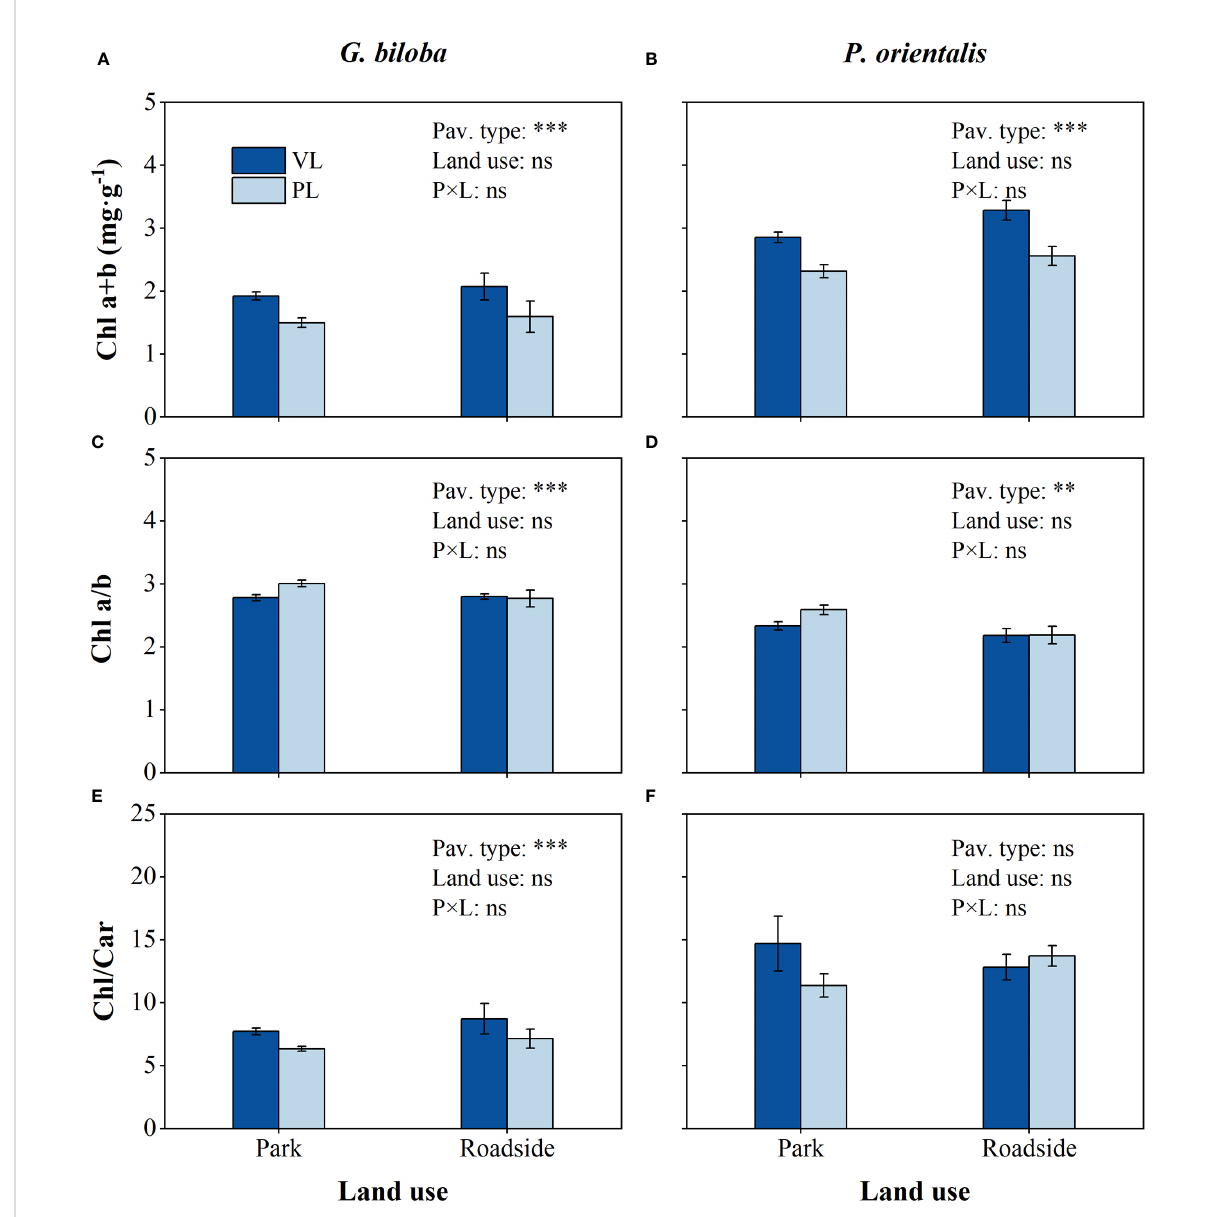
FIGURE 6 Results from the linear mixed-effects model (LMM) testing for the differences in the content of Chl a+b (A, B) , Chl a/b (C, D) , and Chl/Car (E, F) vs. the pavement type (VL, vegetated land; PL, paved land), land use (park and roadside), and their interactions. **, P < 0.01; ***, P < 0.001; ns, not signi fi cant. Data represent mean ±